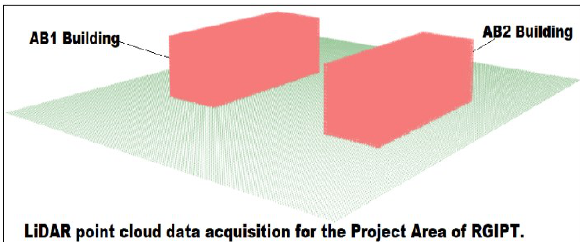
Figure 2. LiDAR data for the selected Project area